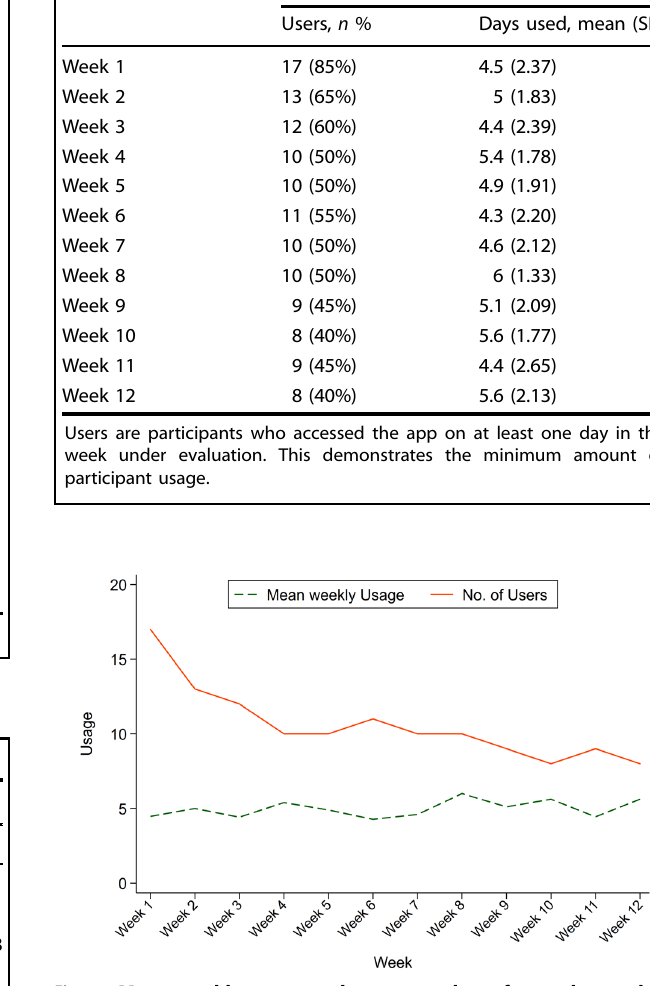
Fig. 2 Mean weekly usage and mean number of users by week of the trial. Indicated is the mean weekly usage (green) and number of users of the app (red) over the 12 week study period. Mean weekly usage is the number of days per week that the app was accessed. The number of users is the number of participants that used the app at least once in that